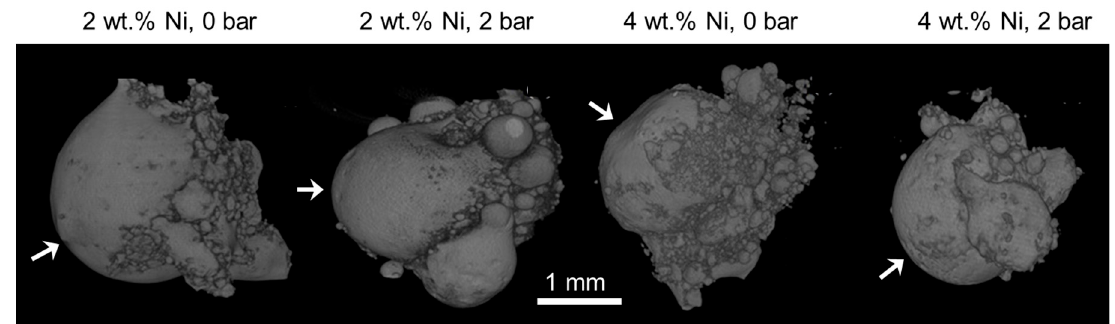
Figure 4. Overall shape of the produced samples reconstructured from μ -CT scans. The arrows indicate the direction of laser beam incidence during the fabrication process.